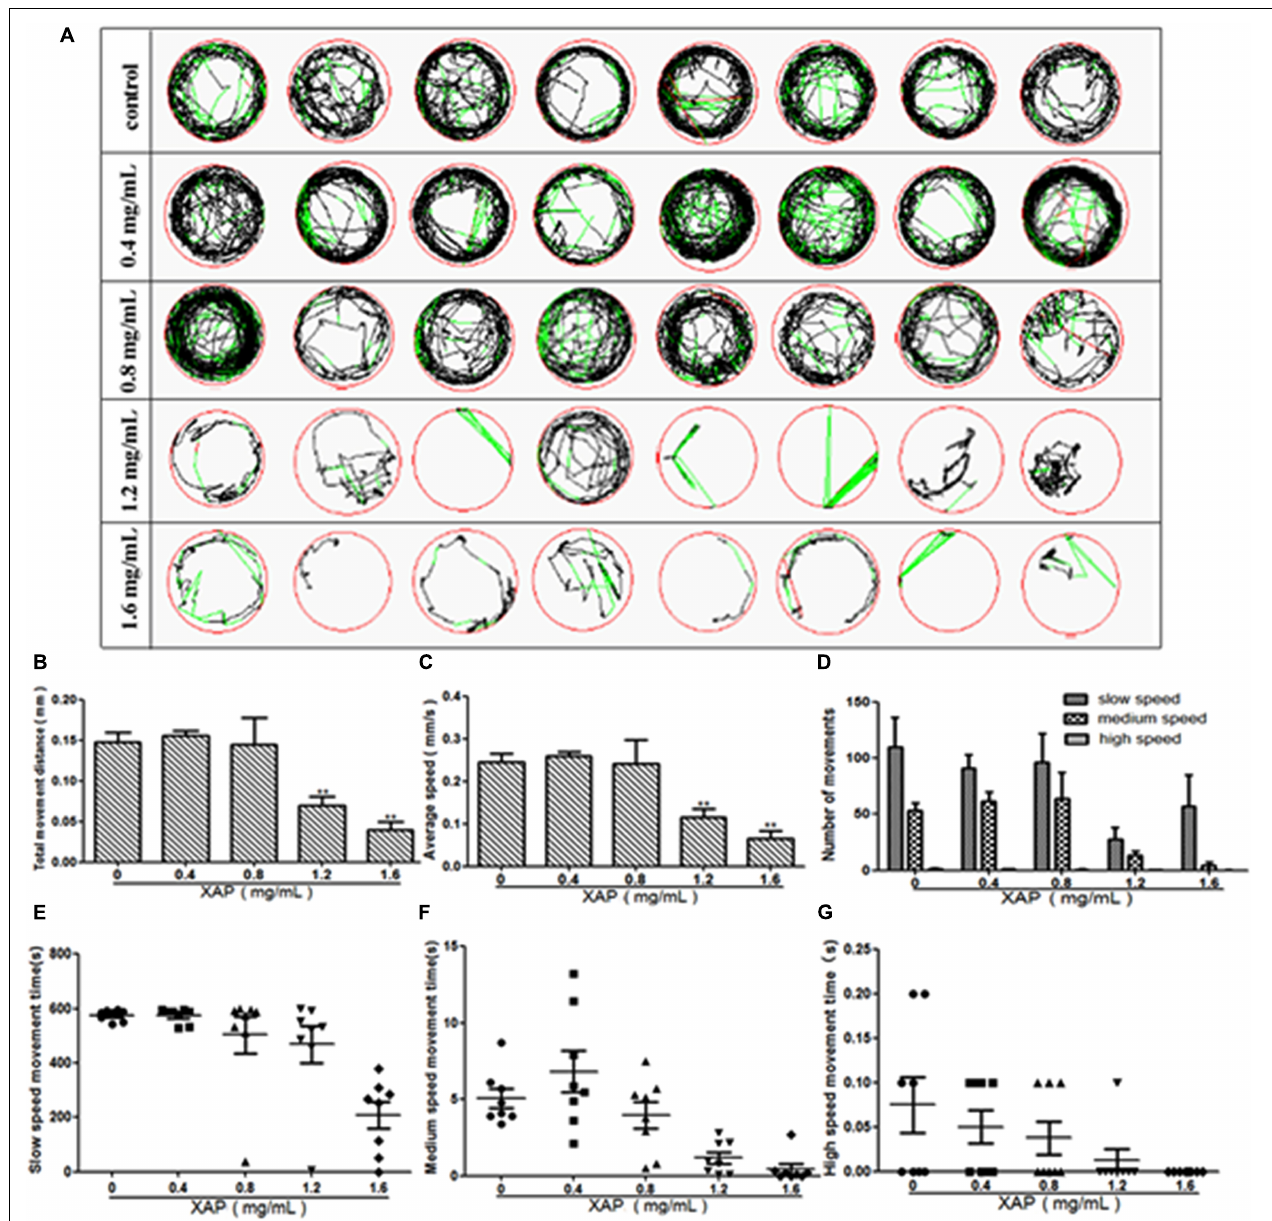
FIGURE 3 | Reduction of locomotor capacity following exposure to XAP. (A) Digital tracks of larvae from the 0, 0.4, 0.8, 1.2, and 1.6 mg/mL exposed groups at 120 hpe. (B) Total movement distance, (C) average speed, (D) number of movements, and (E–G) the average speed of larvae exposed to 0, 0.4, 0.8, 1.2,